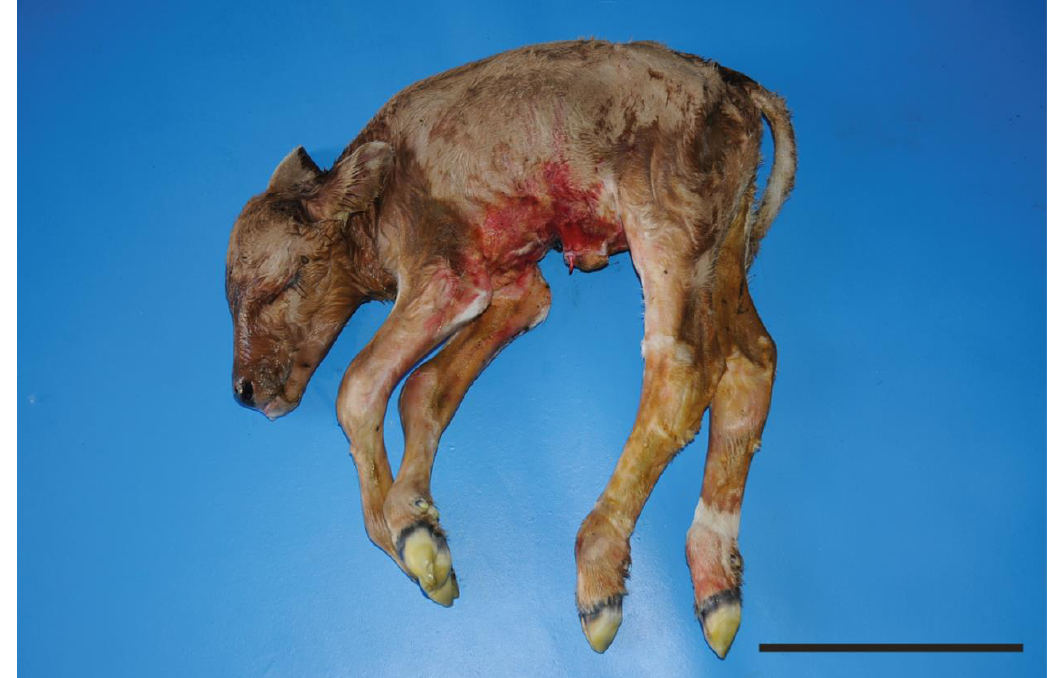
Figure 1. Stillborn Romagnola calf with skeletal-cardio-enteric dysplasia: Strikingly, the length of the spine appeared disproportionately short for the height and legs. Mild kyphosis of the thoraco-lumbar vertebral column is also evident. Bar, 30 cm.